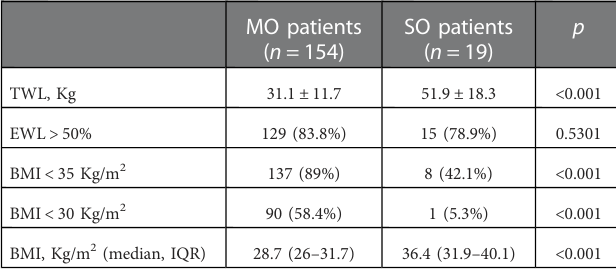
TABLE 3 Results at 24-month